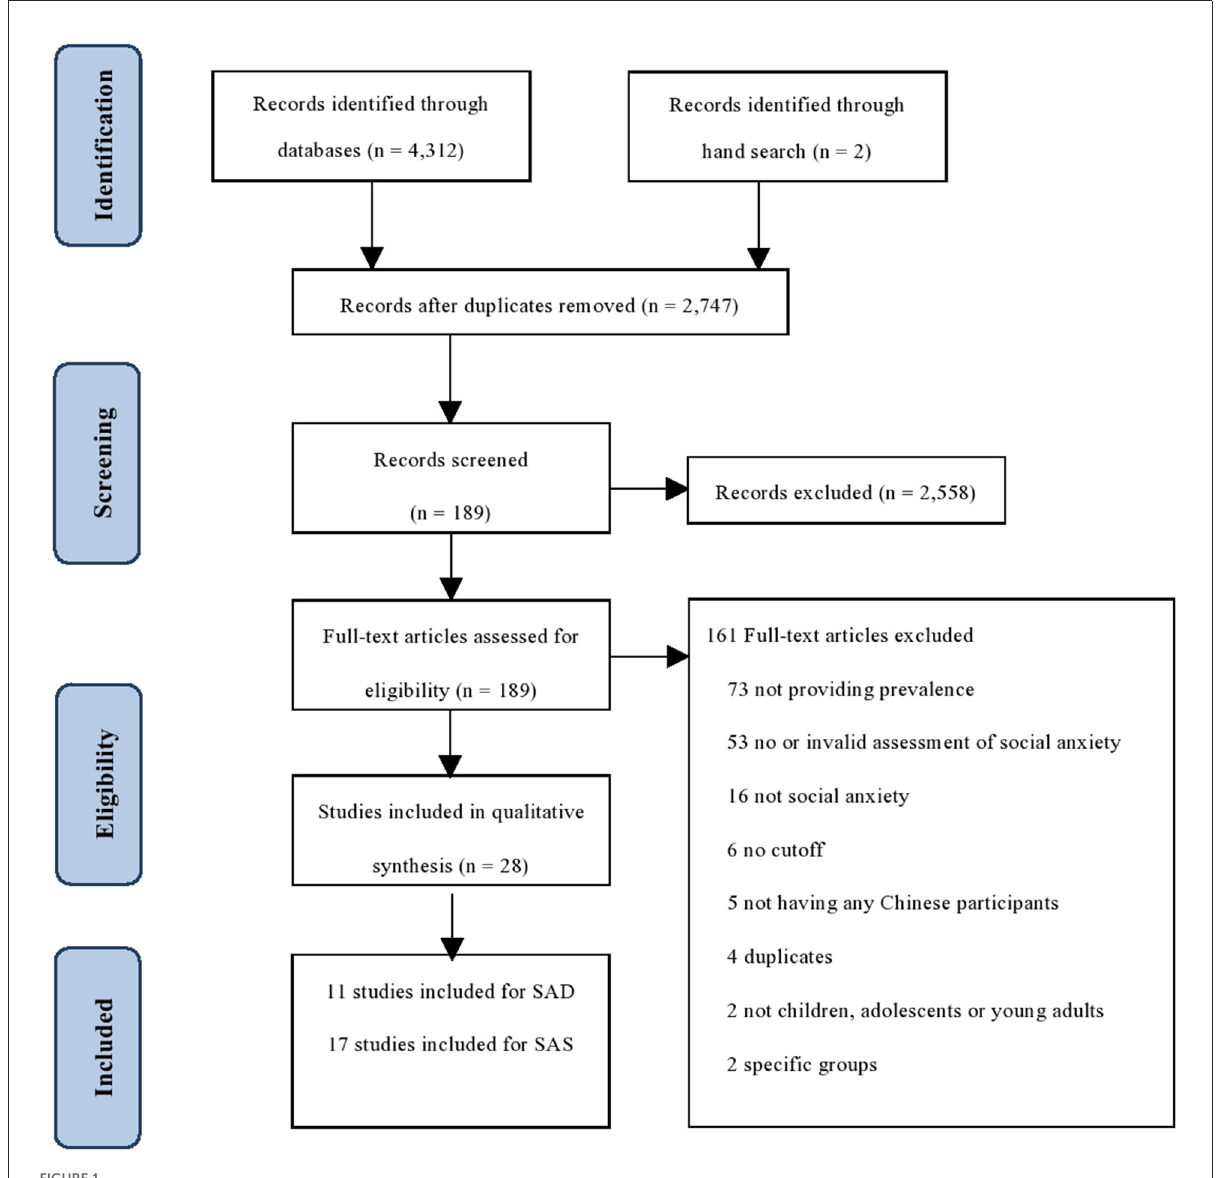
FIGURE1 PRISMA flowchart of study